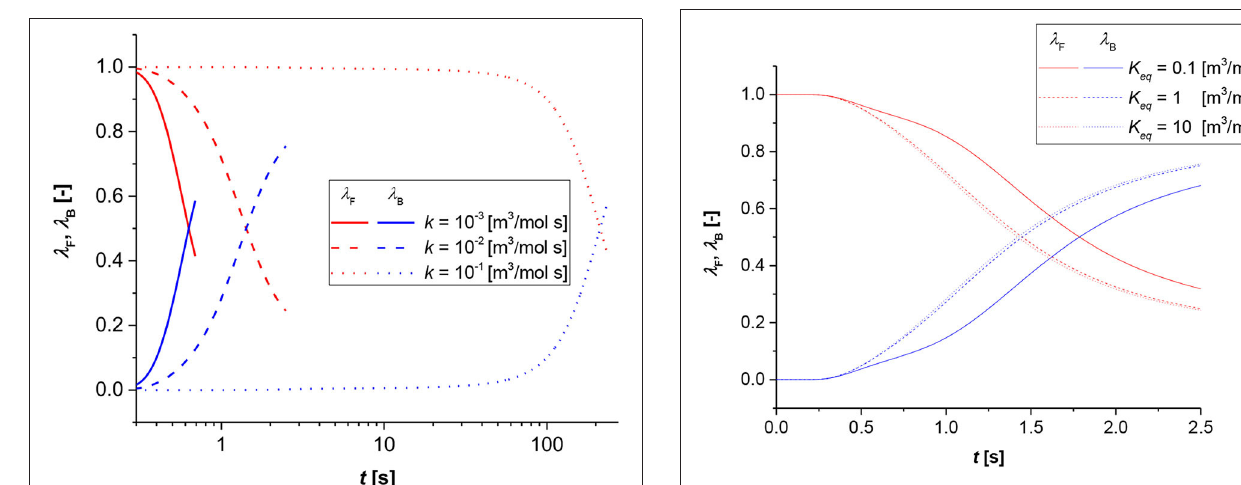
FIGURE 4 | Contribution analysis results for bulk (blue lines) and film (red lines). Simulation conditions D i = 1 × 10 − 9 [m 2 /s], R 0 = 1 × 10 − 3 [m], K eq = 0.1 [-].